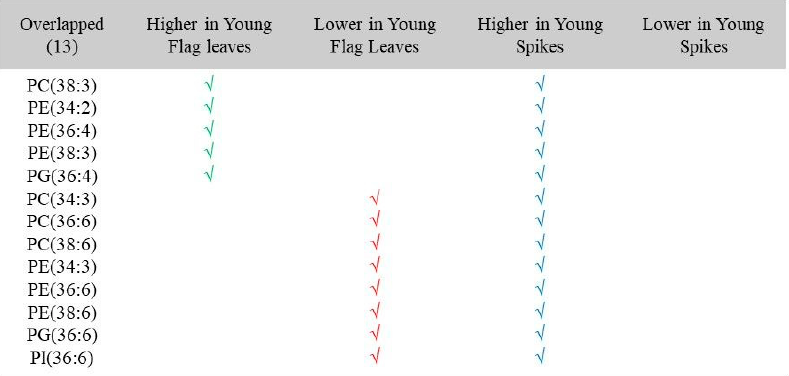
Figure 8. Di ff erences in di ff erentially expressed lipid species between flag leaves and spikes of cold-tolerant Young and cold-sensitive Wyalkatchem. The Venn diagrams show the degree of overlap between di ff erentially expressed cold-induced lipid species in flag leaves and spikes for Young and Wyalkatchem. Thirteen lipid species were commonly expressed in flag leaves and spikes at TP 1 and TP 3 . The table below the diagram shows how these 13 lipid species are expressed di ff erently in flag leaves and spikes of Wyalkatchem and Young.